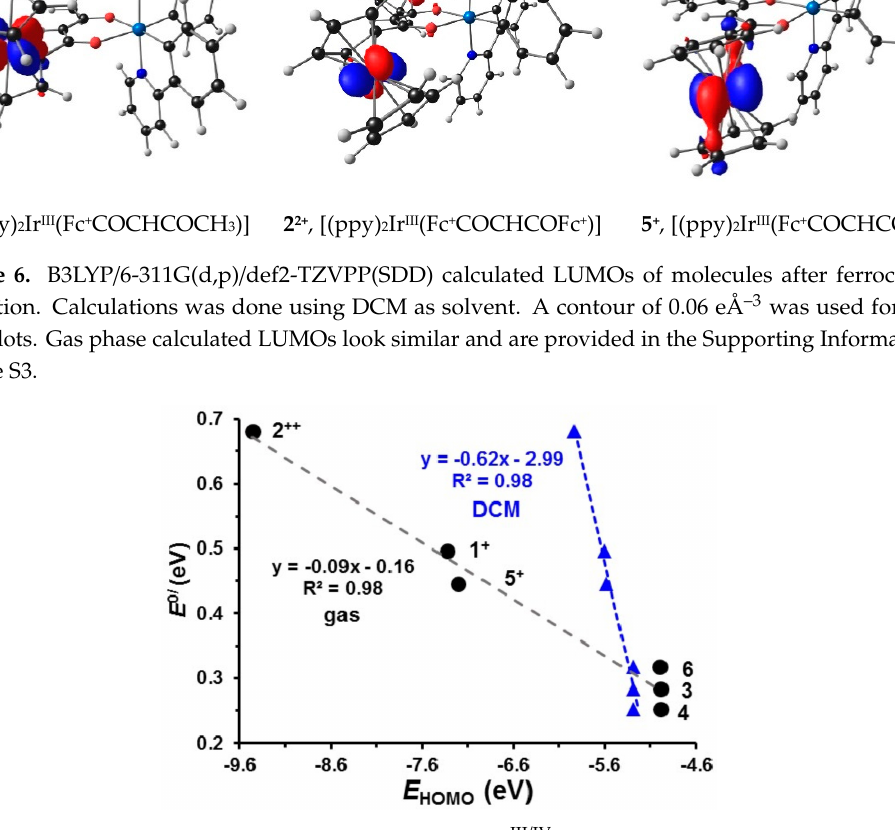
Figure 7. Relationship between the redox potential of the Ir III / IV couple and the HOMO energy ( E HOMO ) of the species involved. The black data points were obtained by DFT calculations in gas phase, while the blue data points were obtained using DCM as solvent in the DFT calculations. Data in Table S9 of the Supporting